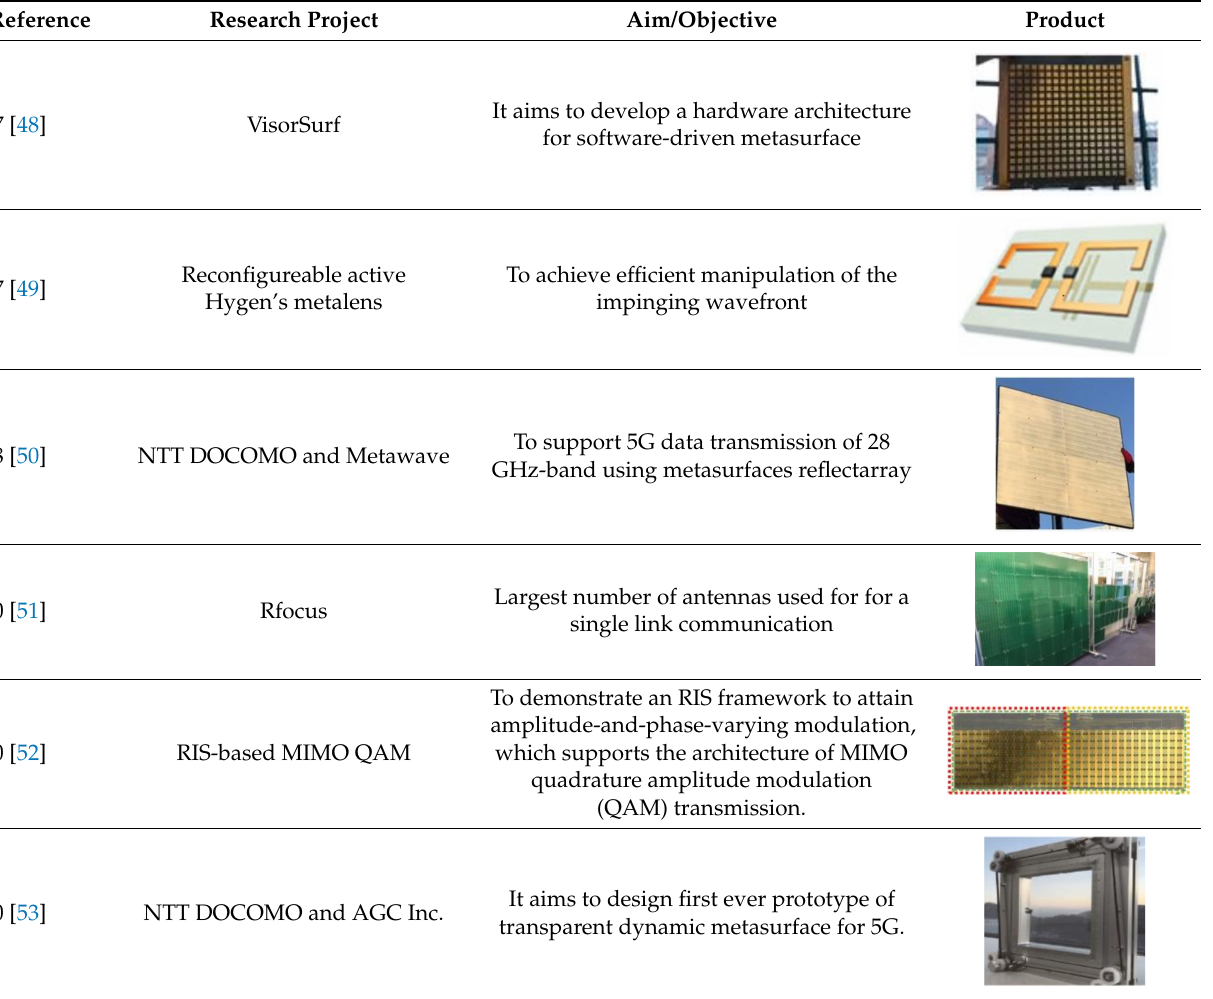
Table 4. Academic and industrial projects on intelligent reflecting